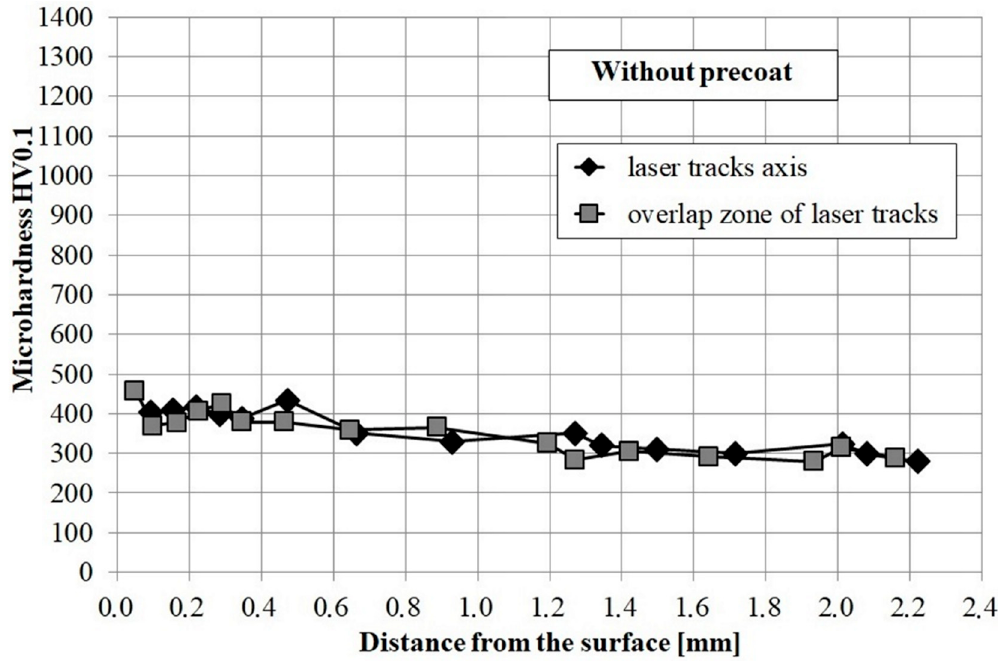
Figure 7. Microhardness of CT90 steel after laser modification.